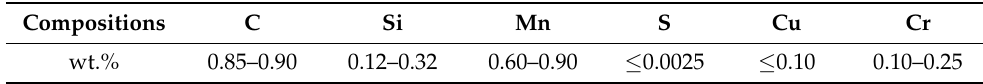
Figure 5. Cross section of boom. Table 1. Chemical compositions (wt.%) of steel wires.